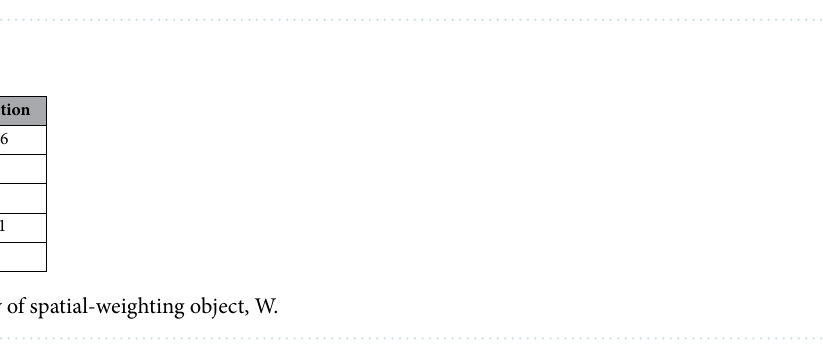
Figure 6. Map of Nigeria Showing the Six Geopolitical Zones (top) and Monthly distribution of Precipitation of Nigeria (bottom).